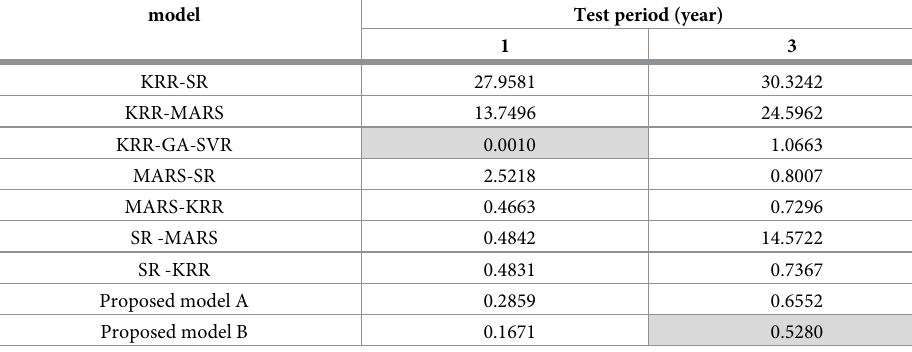
Table 11. Performance comparisons for Cathay Financial Holdings.